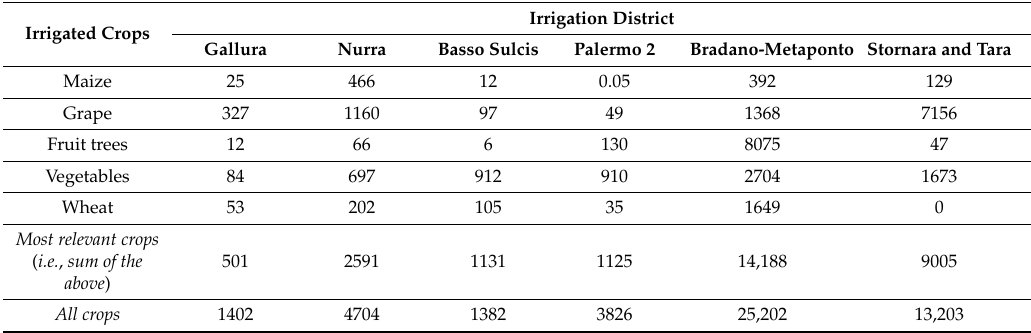
Table 3. Distribution of the main and the total irrigated crops in each irrigation districts in hectares [64,66].